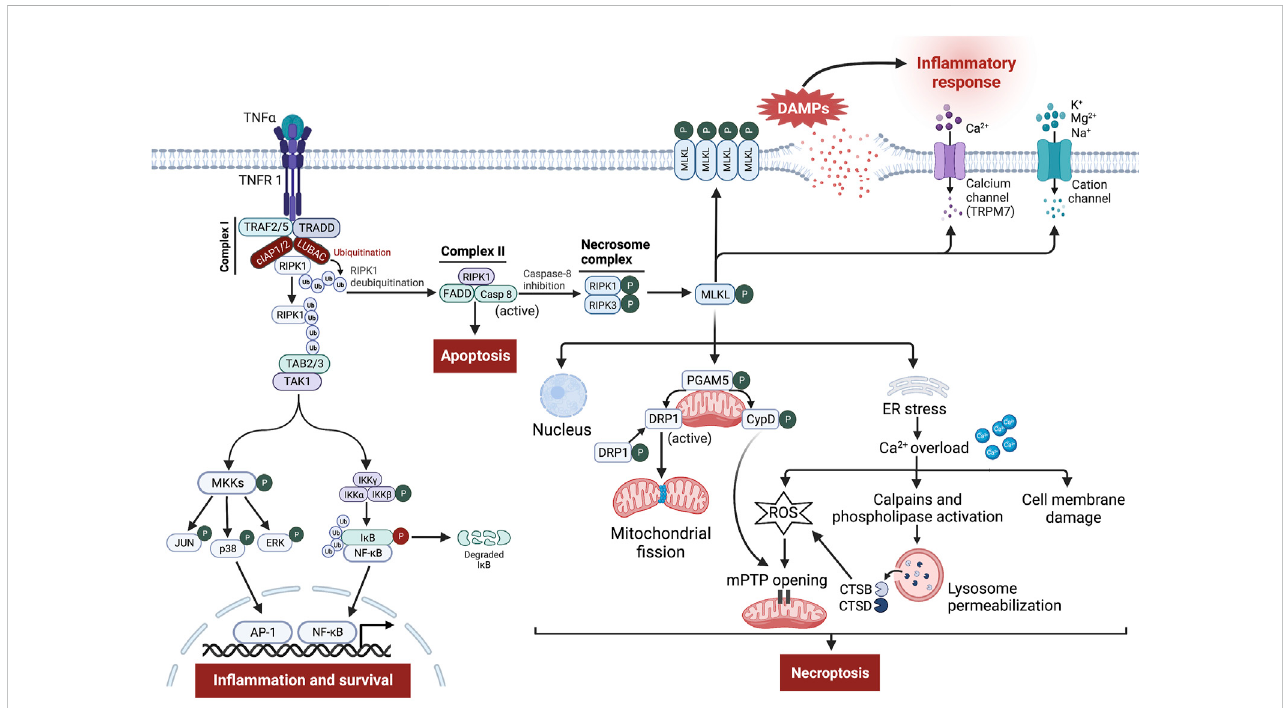
FIGURE 3 Signaling pathway leading to tumor necrosis factor- α (TNF- α )-receptor 1 (TNFR 1)-mediated necroptosis. Ligation of TNF- α to TNFR1 leads to the generation of the membrane-bound complex I, in which cellular inhibitor of apoptosis proteins (cIAPs) and linear ubiquitin chain assembly complex (LUBAC) polyubiquitinatereceptor-interacting proteinkinase(RIPK)-1(RIPK1),directing ittowardsproteasomaldegradationandstabilize complexI,whichcontributes to in fl ammation and cell survival through stimulation of nuclear factor kappa B (NF- κ B) and mitogen-activated protein kinase (MAPK)